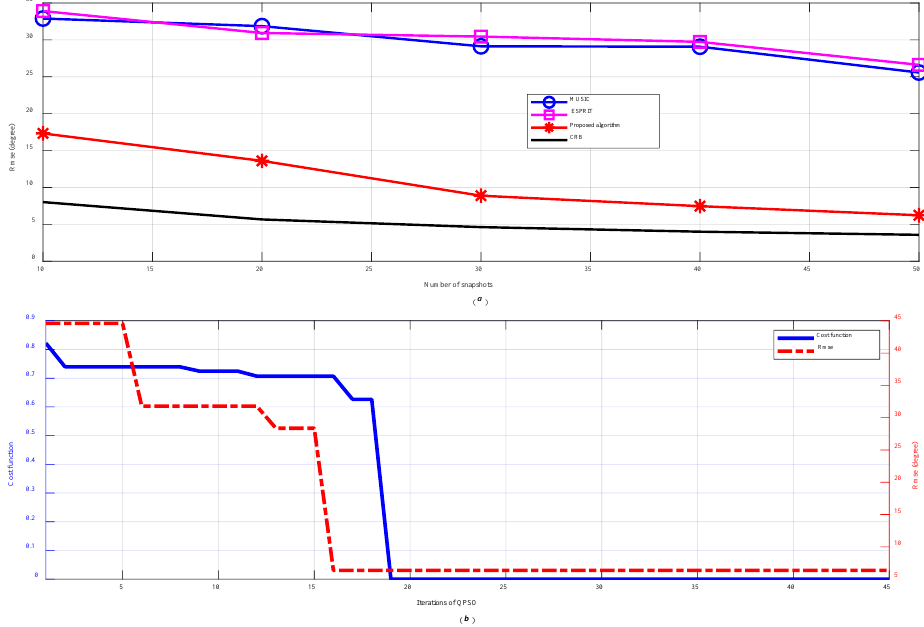
Figure 3. ( a ) Root mean square errors (RMSE) versus number of snapshots (signals with the same signal-to-noise ratio (SNR)). ( b ) The cost function and the RMSE versus the number of iterations.